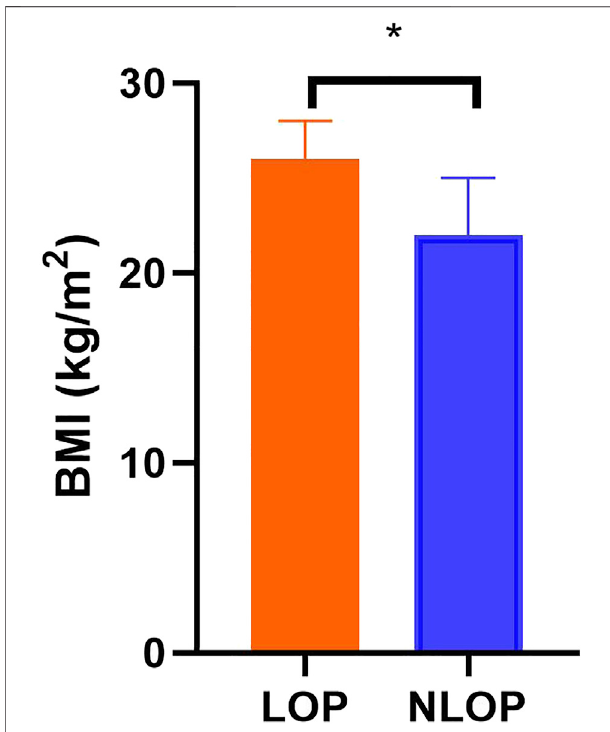
FIGURE 1 | Body mass index of the two groups. Patients in the LOP grouphadhigherbodymassindexcomparedwiththeNLOPgroup.* p < 0.05 compared with the LOP